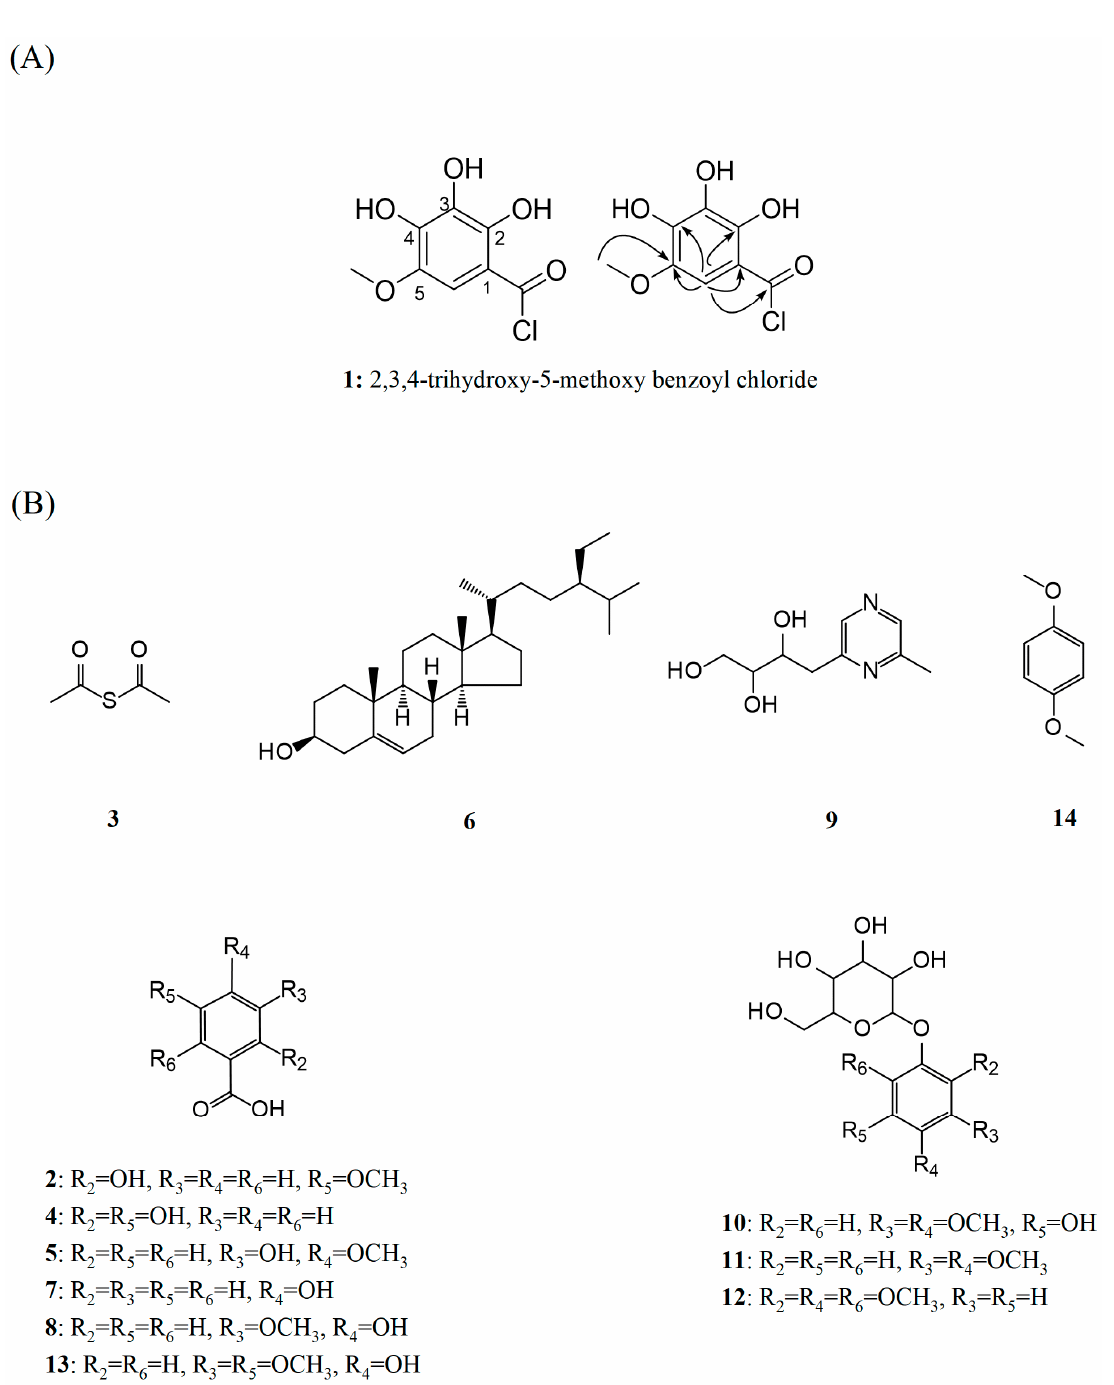
Figure 1. ( A ) Structure and HMBC of compound 1 ; ( B ) the structures of 13 known